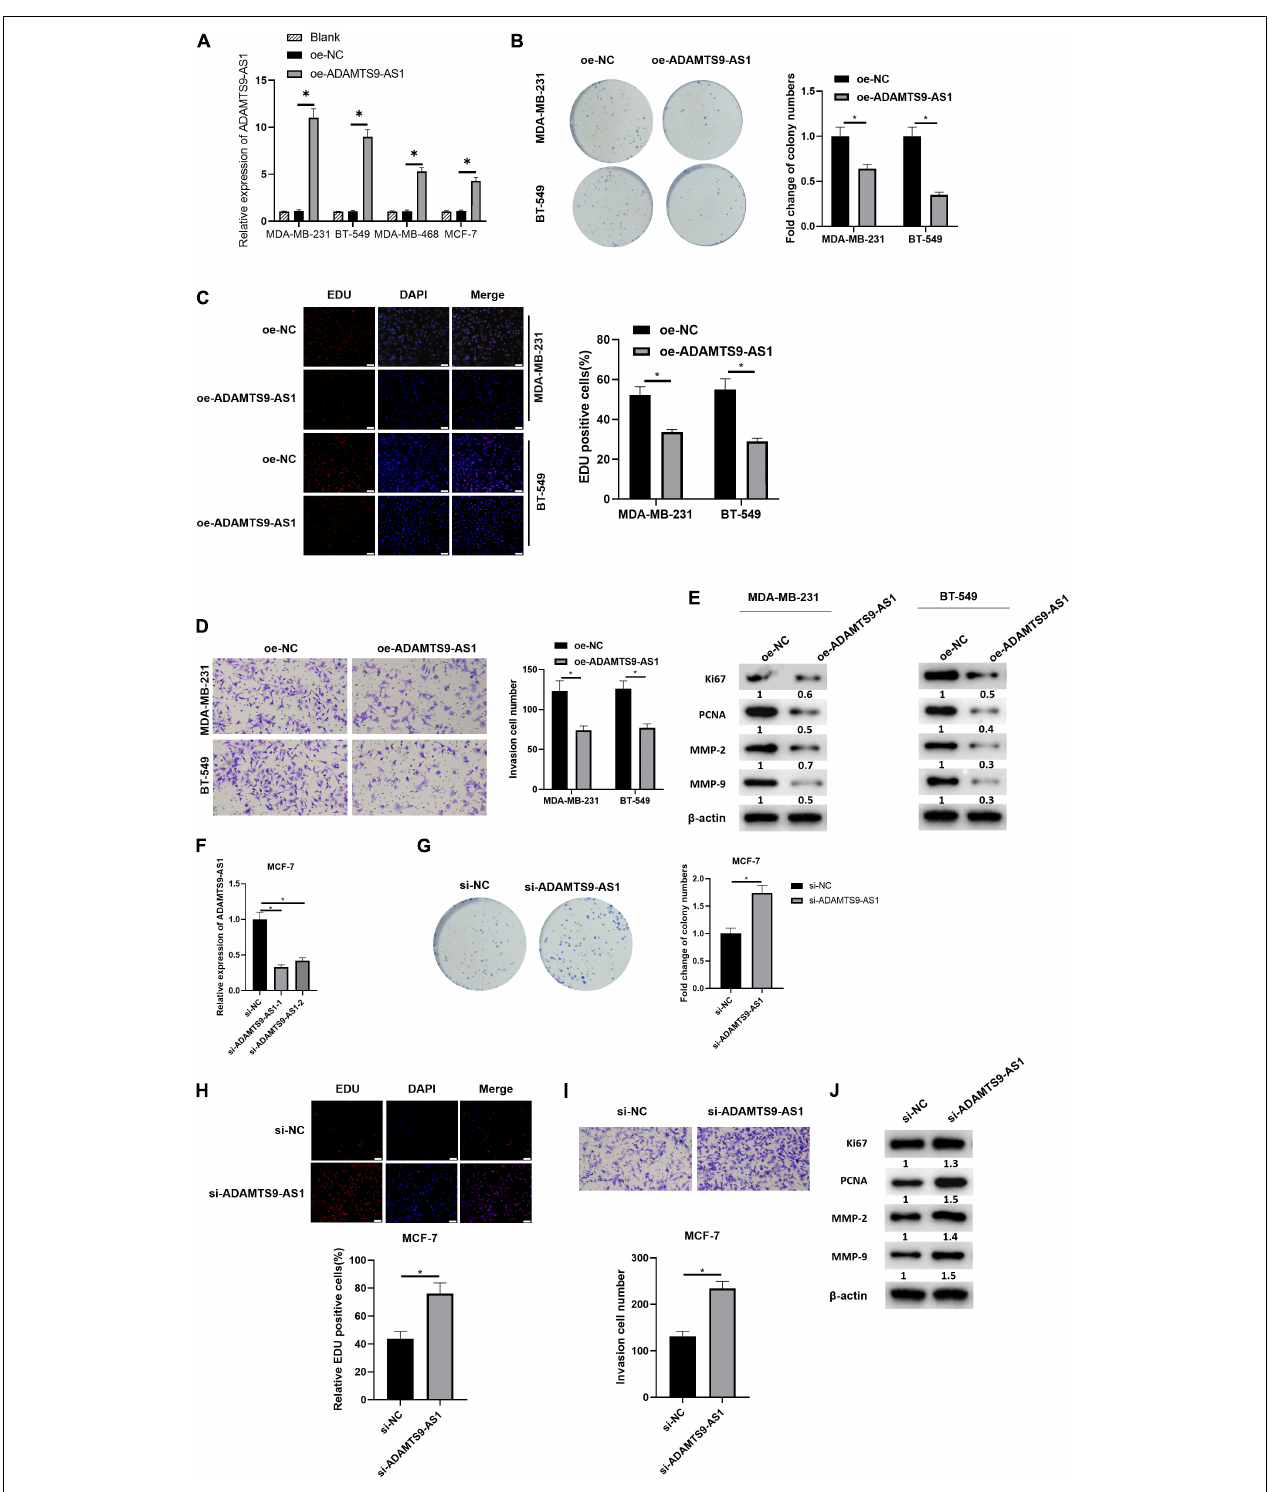
FIGURE 2 | ADAMTS9-AS1 restrains cancer cell invasion and proliferation. ADAMTS9-AS1 was overexpressed in MDA-MB-231 and BT-549, while being silenced in MCF7. (A) Level of ADAMTS9-AS1 in breast cancer cells. (B) Results of in vitro colony formation method. (C) Results of EdU method (400 × ). (D) Cell invasion results (100 × ). (E) The expression of Ki67, PCNA, MMP-2 and MMP-9 after interfering with ADAMTS9-AS1 expression. (F) ADAMTS9-AS1 level in cancer cells. (G) Proliferation of cancer cells. (H) Results of EdU method (400 × ). (I) Transwell method is used to test cell invasion (100 × ). (J) The expression of Ki67, PCNA, MMP-2 and MMP-9. * p <